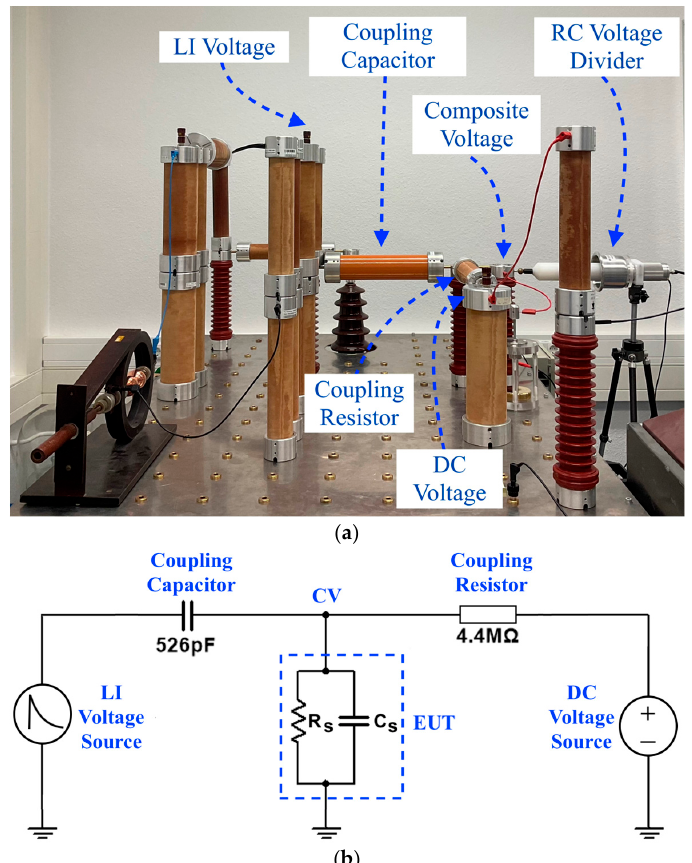
Figure 6. The waveforms obtained as a result of the analysis made with 320 k Ω coupling resistor.